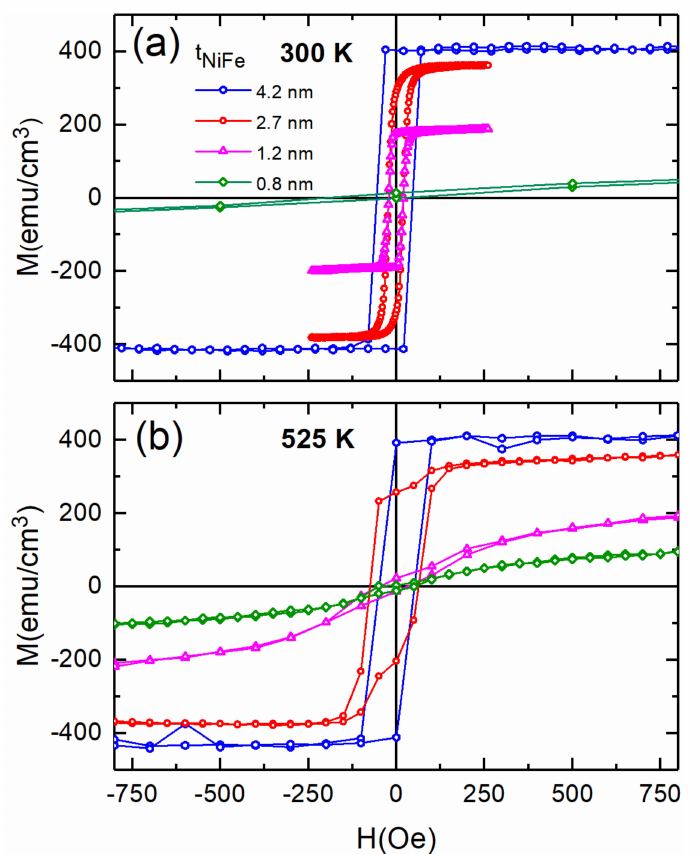
Figure 4. RT longitudinal MOKE hysteresis loops (H is applied parallel to the film plane) for four NiFe/NiFeO multilayers with t NiFe as indicated before ( a ) and after annealing at 525 K for 90 min ( b